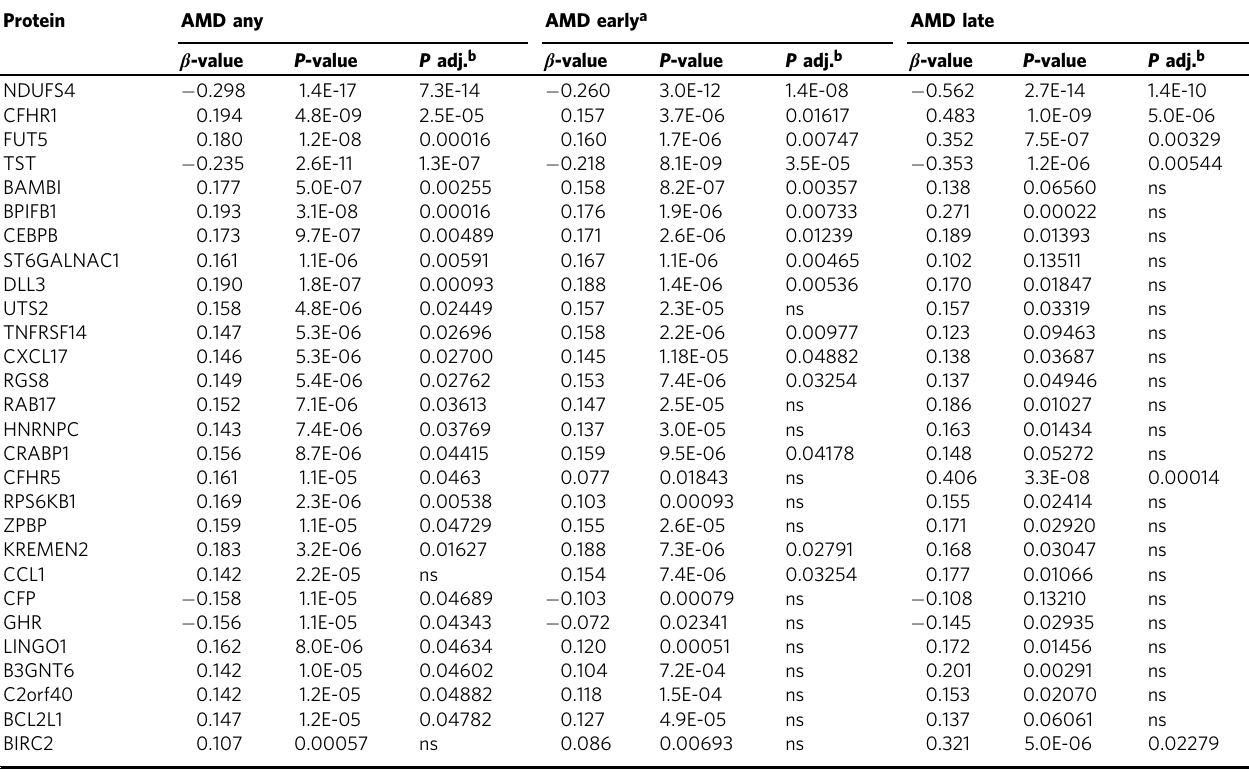
Table 1 Serum proteins signi fi cantly associated with prevalent AMD using logistic regression analysis. Protein AMD any AMD early a AMD late β -value